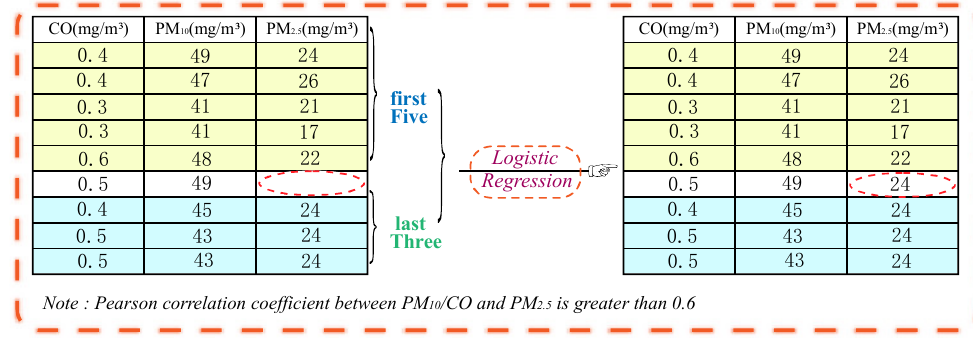
Figure 3. An example of FTLRI.